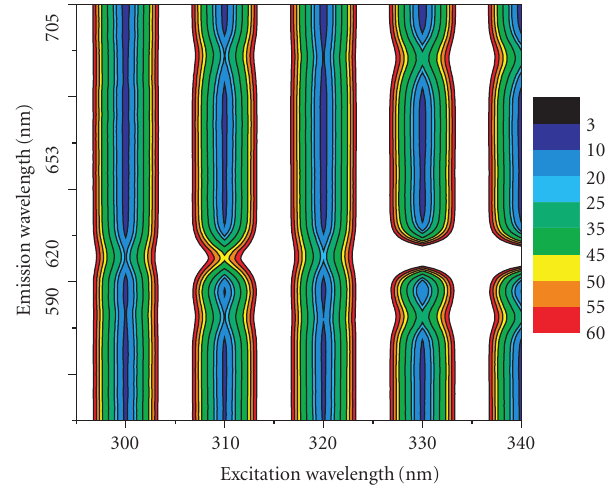
Figure 9: Contour view of the emission spectra of Eu 3+ ion in Eu- (III) complex at di ff erent excitation wavelengths in DMSO. The excitation/emission matrix represents the